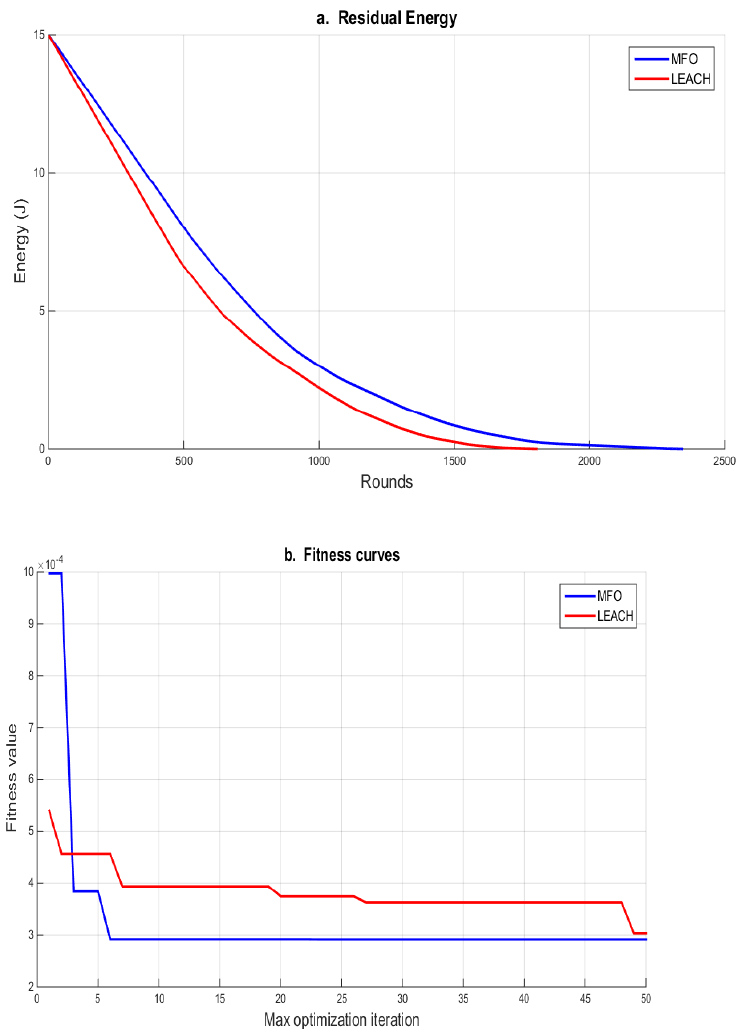
Figure 9. ( a ) The number of rounds versus the residual energy within MFO and LEACH. ( b ) The number of rounds versus fitness function for MFO and LEACH.